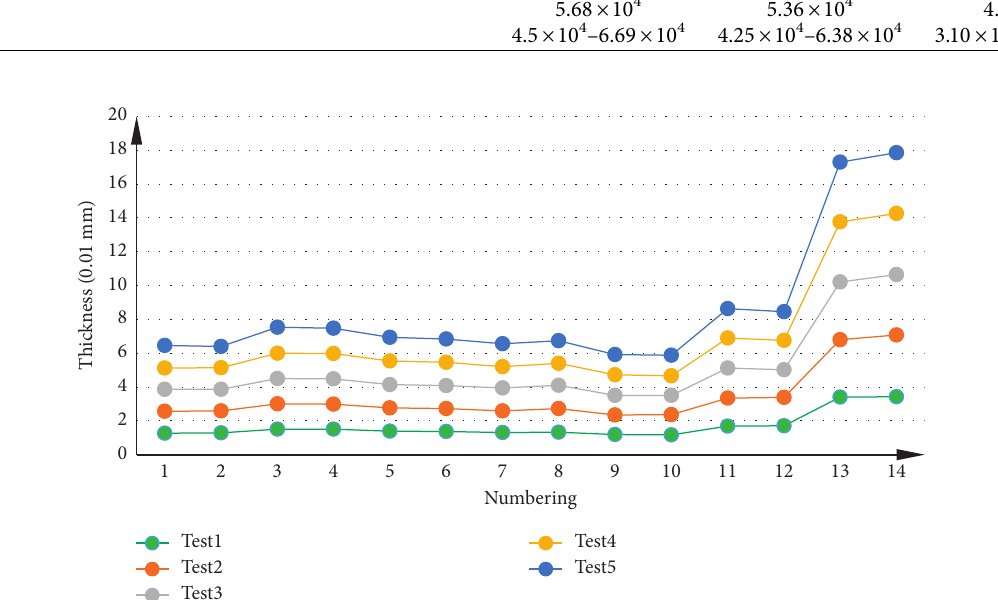
Table 5: Antibacterial effect of “nano-mite-proof silk knitted garment fabric” on Escherichia coli . The average bacteriostatic rate and range of different action time (%) Average number of colonies and range of positive control group